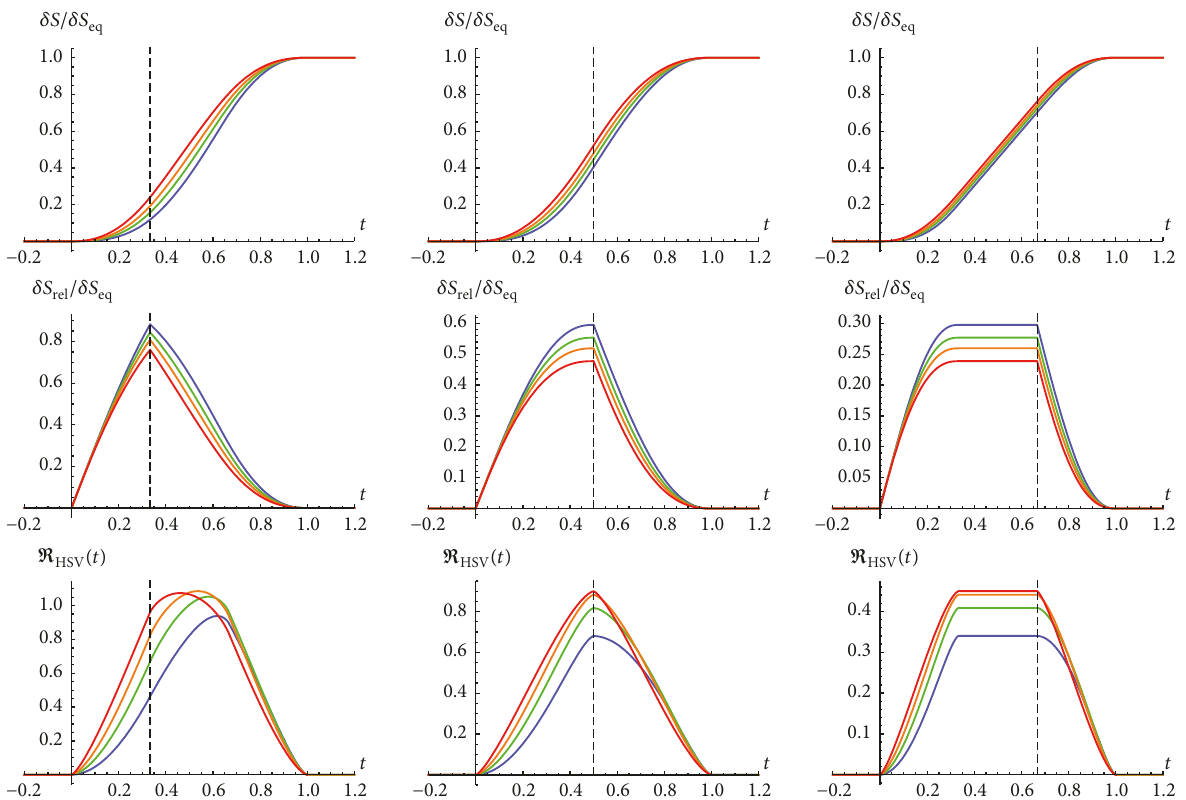
Figure 9: Entanglement entropy, relative entropy, and entanglement velocity for different values of 𝑧 . Colors blue, green, orange, and red represent 𝑧 = {1.1,1.5,2, 3} , respectively. Plots from left to right have 𝑡 𝑞 /𝑡 ∗ = {0.5,1,2} . In all plots, the dashed vertical line denotes the end of the driven phase 𝑡 = 𝑡 𝑞 . We have set 𝑑 = 3 , 𝑝 = 1 , and 𝜃 = 0.1